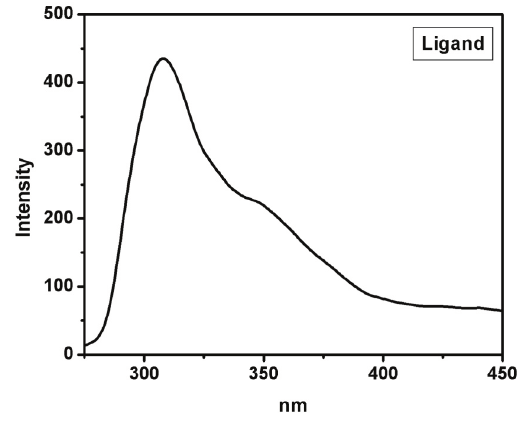
Figure 3: Fluorescence spectrum of L.